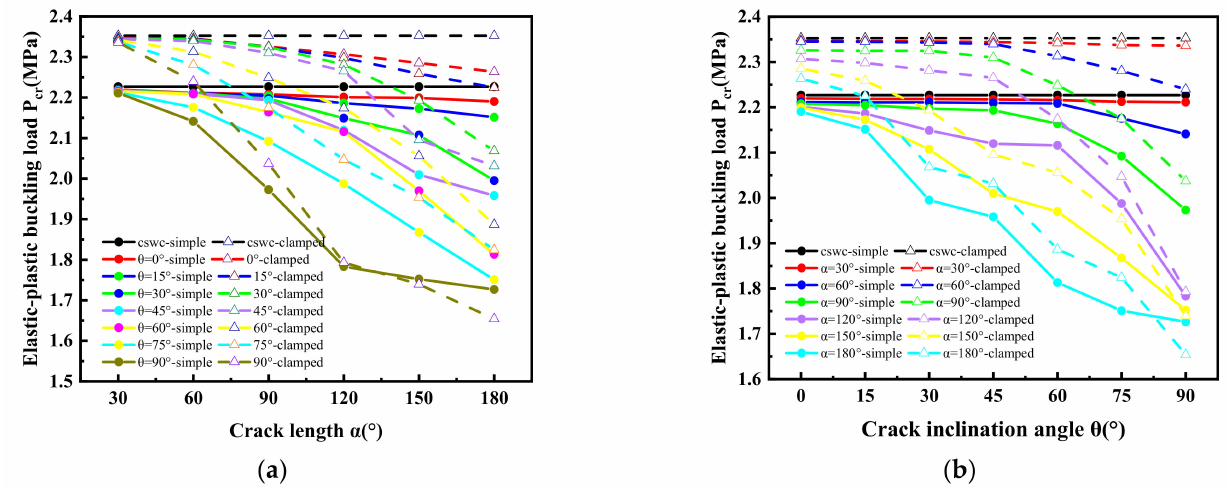
Figure 13. Relation between crack length and elastic-plastic buckling load with clamped support at both ends of cylinder ( a ) Different crack lengths; ( b ) Different crack inclination angles.